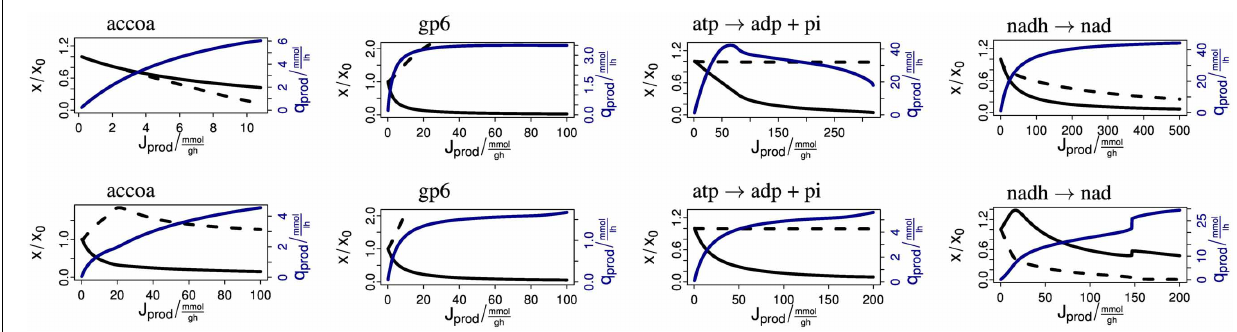
concentration of the respective metabolite. The curves are scaled to the undisturbed case and start at unity. The blue lines show the productivity in mmol/l/h. Labels mean accoa acetyl-CoA, g6p glucose 6-phosphate, atp → adp + pi dephosphorylation of ATP, nadh → nad oxidation of